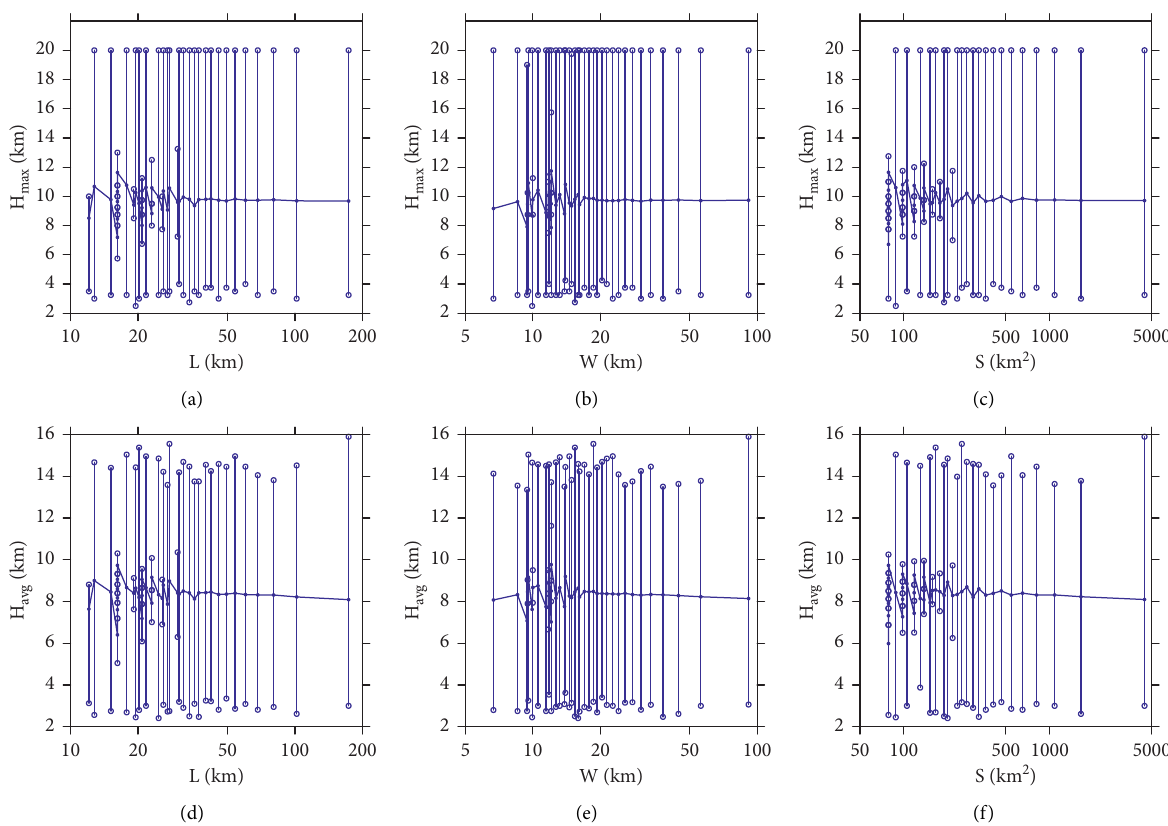
Figure 8: The relationship between H max and L (a), H max and W (b), H max and S (c), H avg and L (d), H avg and W (e), and H avg and S (f) on Tibetan Plateau from 1998 to 2015 based on the statistical principle of same samples in each interval at x